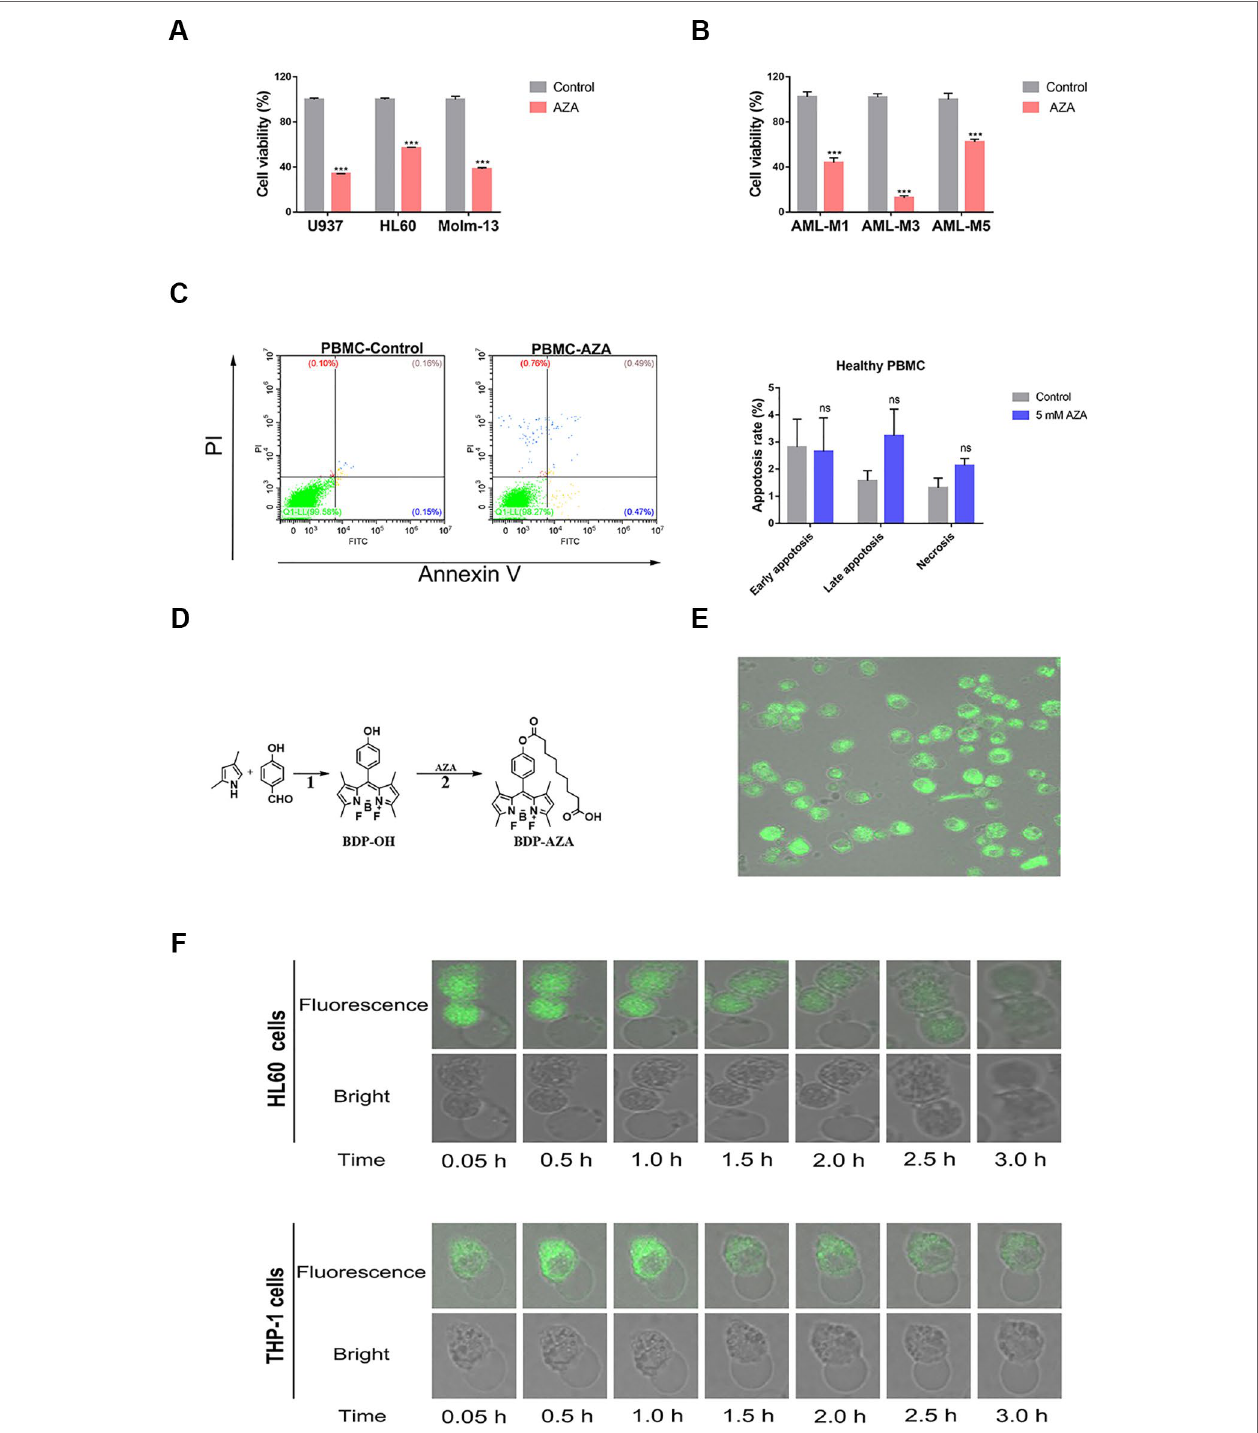
FIgUrE 1 | Azelaic acid (AZA) inhibits acute myeloid leukemia (AML) cell proliferation. (A) The U937, HL60, and Molm-13 cells were treated with AZA at concentration of 5.0 mM for 48 h. Cell viability was measured by the CCK-8 method. (B) AML patient cells were isolated and then treated with 5 mM AZA for 48 h. Cell viability was measured by the CCK-8 method. (c) Peripheral mononuclear cells (PBMC) were treated with 5 mM AZA and then stained with Annexin V/PI. The apoptotic rate was measured by flow cytometry analysis. (D) The synthetic method of BDP-AZA. (E) HL60 cells were cultured in confocal dish for 24 h and 1 mM BDP-AZA was added to the medium. Thereafter, cell membrane was observed to turn green with confocal microscope under the excitation of blue light. (F) HL60 and THP-1 cells began to develop swelling and cytoplasmic vacuolization under fluorescence confocal microscopy after AZA treatment. A total of three independent experiments were performed, ***P < 0.001. ns, no